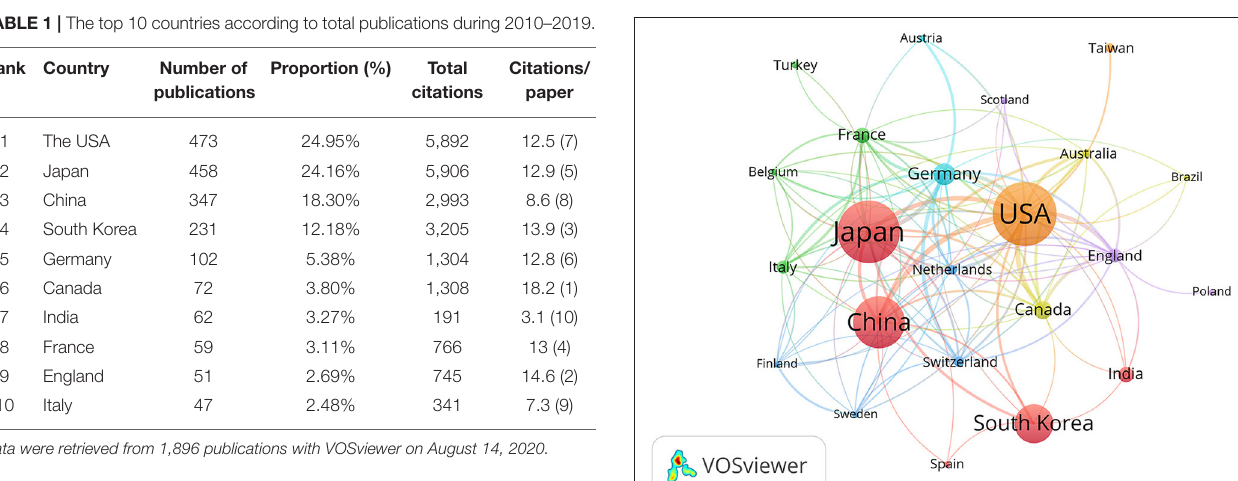
had a minimum threshold of 10 publications. As shown in the network map, a variety of institutions closely cooperation with each